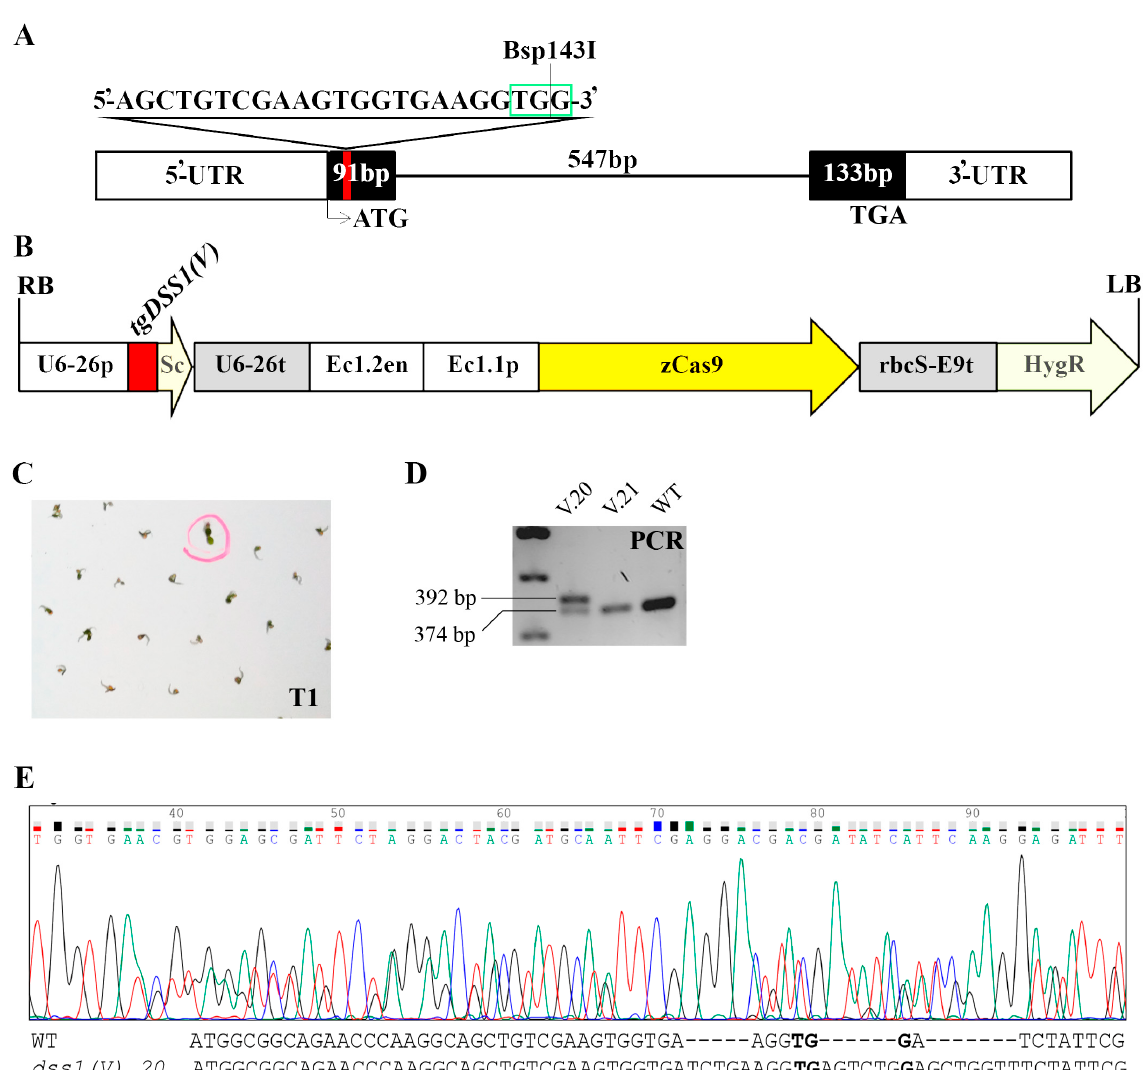
Figure 3. Construction strategy for AtDSS1(V) gene editing by CRISPR/Cas9 via Agrobacterium -mediated transformation of Arabidopsis and mutant screening approaches. ( A ) Schematic diagram of the AtDSS1(V) gene indicating the sgRNA target site ( tgDSS1(V) ) (red line), its sequence with PAM (green square), and Bsp143I restriction site; 5’ and 3’ UTRs are shown as white boxes; exons are shown as black boxes; the line indicates intron position; ATG is start codon and TGA is stop codon. ( B ) Structure of the CRISPR/Cas9 binary vectors pHEE401E for Arabidopsis transformation: tgDSS1(V) was controlled by the U6-26p–U6 promoter for PolIII; Sc-scaffold; the Cas9 cassette was driven by the EC1.2en and EC1.1p—egg-specific enhancer-promoter combination for zCas9 ( Zea mays codon-optimized Cas9) expression in egg and zygote; rbcS-E9t—terminator of zCas9; Hyg— hygromycin-resistance gene; RB/LB are T-DNA right/left borders. ( C ) The photo of the selection of hygromycin-resistant Arabidopsis seedlings in the T1 generation. ( D ) The electropherogram of DNA fragments amplified by the primers designed to encompass the potential indel sites (plant V.20 with large insertion ( ins ); V.21—example of plant with same PCR fragment length as WT plant). ( E ) Sanger sequencing chromatogram of the generated heterozygous Atdss1(V).20 plants in T2 generation, followed by the alignment of WT and mutant sequence. Bold letters represent PAM sequence. Mutant lines with larger indels ( del 25 nt and ins 18 nt) were selected for further characteri- zation because these mutations were easy to trace in further generations. Plants homozygous for dss1(I) and dss1(V) were selected in the T3 generation by HRM, and their homozygosity